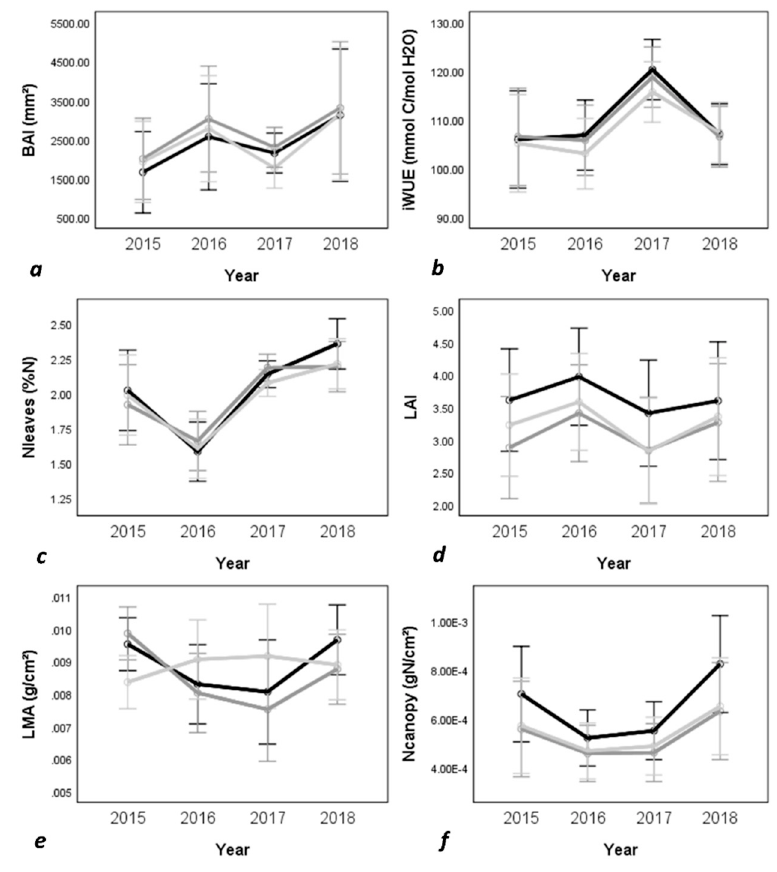
Figure 1. Trend of basal area increment (BAI, a ), intrinsic water use efficiency (iWUE, b ), relative leaf nitrogen content (Nleaves, c ), leaf area index, (LAI, d ), leaf mass per area (LMA, e ) and canopy nitrogen content (Ncanopy, f ), observed in the three different treatments during the 4 years observation period. Data points represent mean values of three plots. SE are shown in vertical bars. Black line = above canopy fertilization; dark grey line = below canopy fertilization; light grey = control).